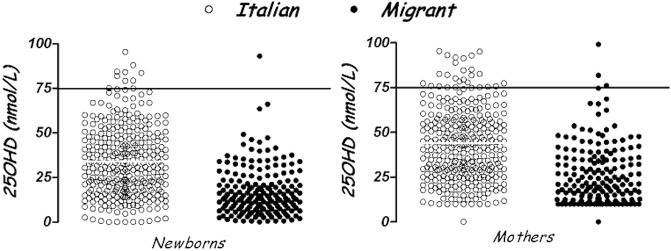
Vitamin D (25OHD) levels (nmol/L) in Italian and migrant mothers and newborns.* = p<0.0001